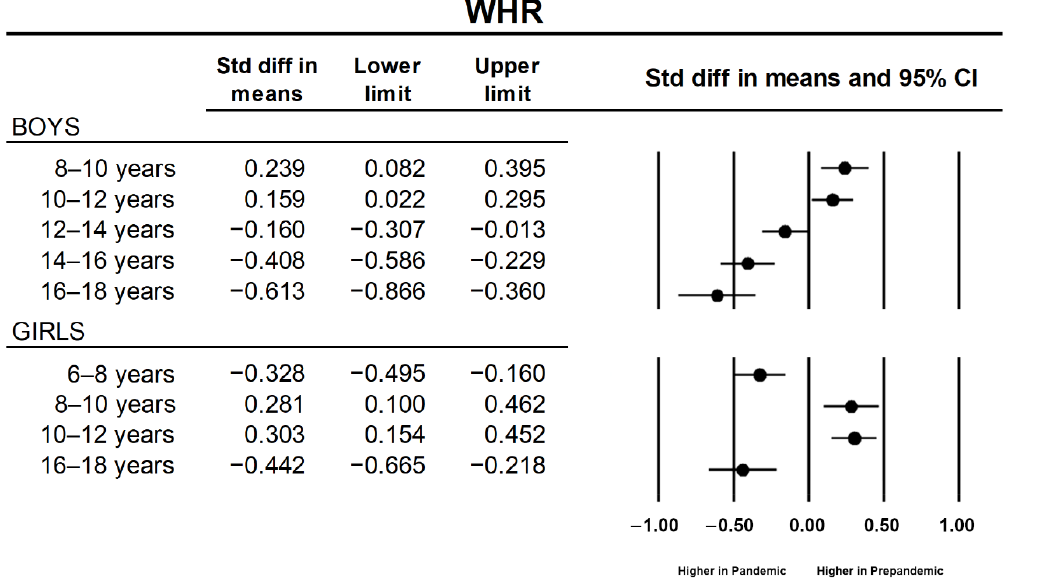
Figure 3. Standardized mean differences (Cohen’s d) between prepandemic and pandemic samples of significant simple pairwise contrasts for waist to hip ratio (WHR).